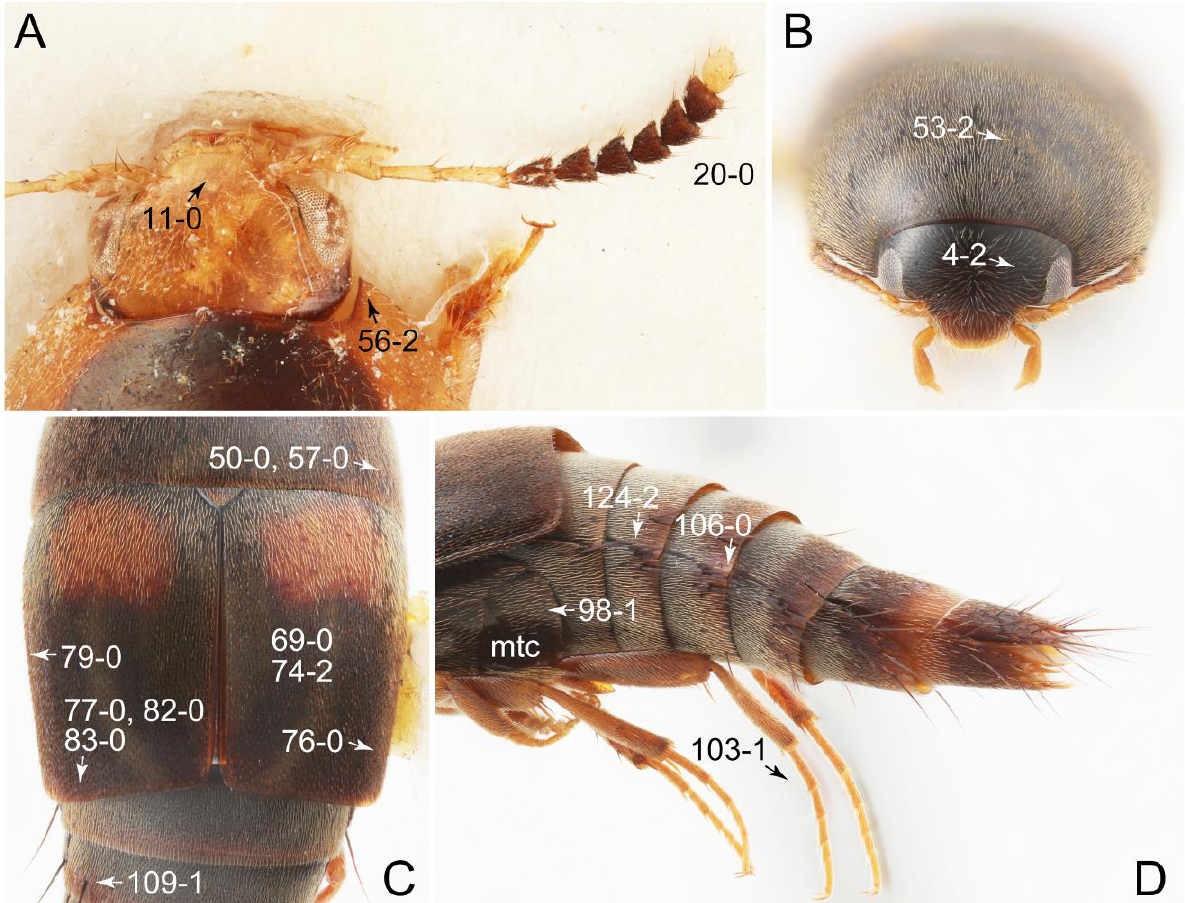
Figure 15. Photographs of body parts of Tachyporini: Euconosomatina, enlarged. ( A ) antenna, head, and pronotum of Euconosoma picta , dorsal view. ( B ) head and pronotum of Sepedophilus bisignatus , frontal view. ( C ) elytra with pronotal and abdominal bases of Sepedophilus bisignatus , dorsal view. ( D ) legs and abdomen of Sepedophilus bisignatus , lateral view. Abbreviation: mtc, metacoxa. Characters and character states (format X-X) are indicated on each